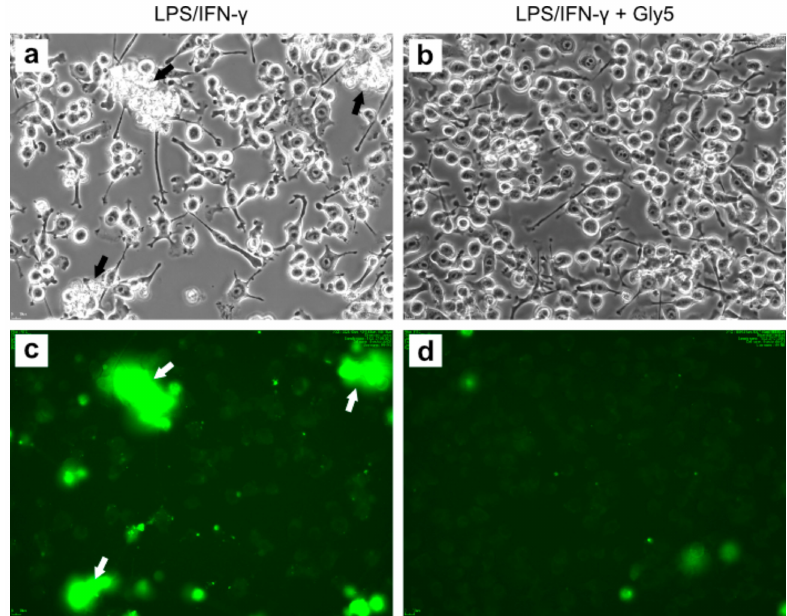
Figure 4. Phase-contrast images ( a , b ) and corresponding fluorescence images of FITC-ANN-V stained ( c , d ) BV-2 cells treated for 24 h with LPS / INF- γ alone ( a , c ) or in the presence of 5 mM glycine ( b , d ). Magnification 20 × . Arrows indicate aggregates of cells which are already apoptotic, or which are about to